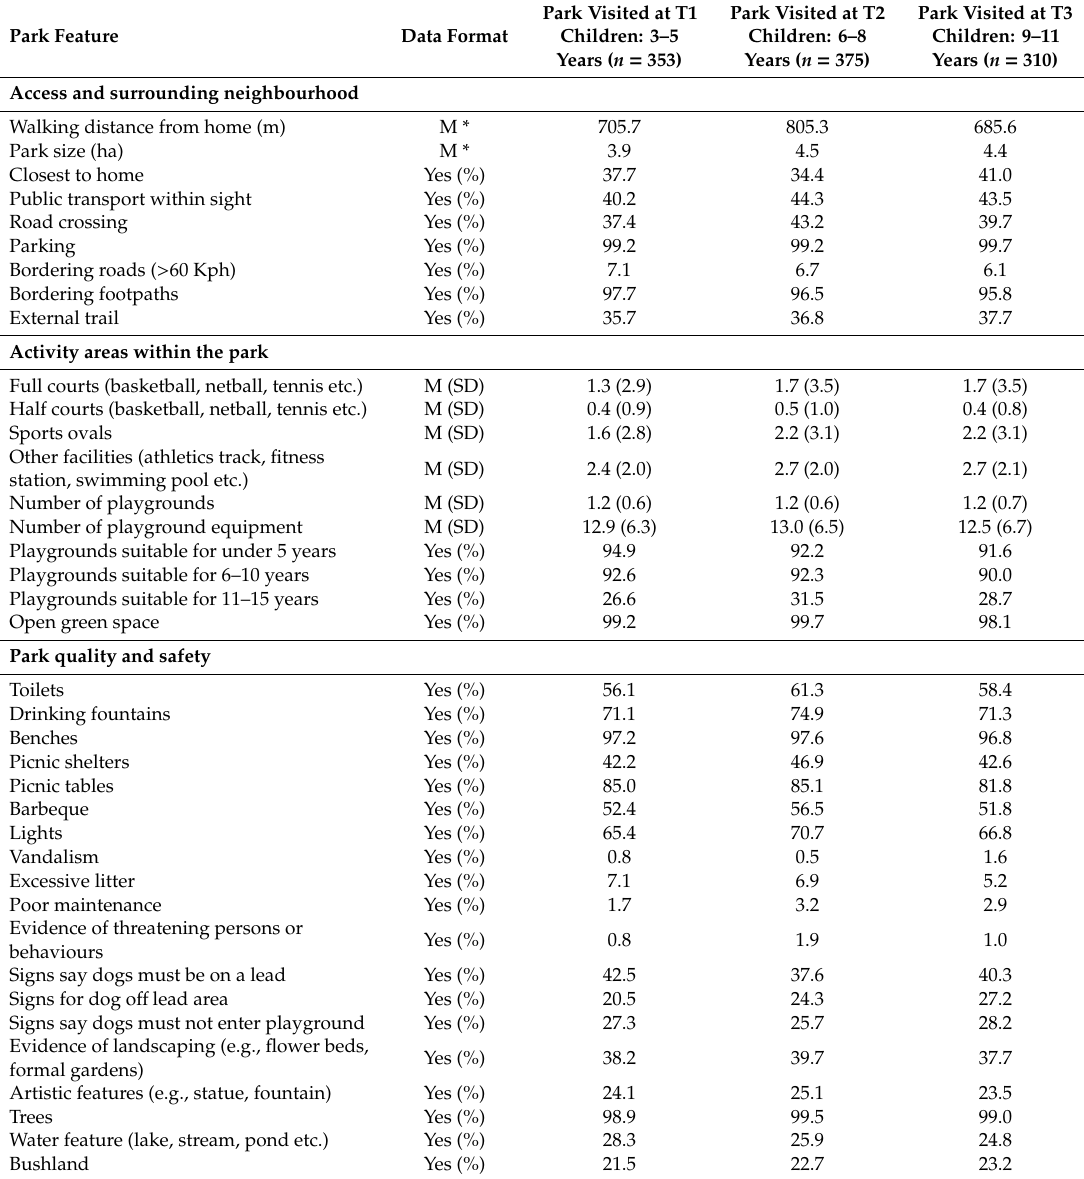
Table 1. Descriptive characteristics of the parks at three